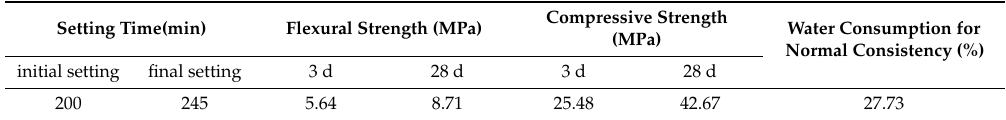
Table 2. Chemical composition of Cement. Table 5. Chemical Composition and Physical Indexes of silica fume.